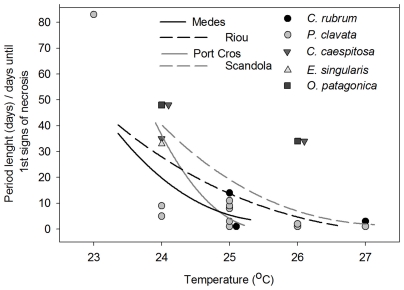
Field T versus experimental thermotolerance data.Inverse second order regression (f = y0+(a/x)+(b/x∧2) fitted to field T data (highest mean T of different length episodes) of the four study regions at 10 m depth (complete and dashed lines) and experimental results (day of 1st signs of necrosis) from different rocky benthic species (grey and black symbols) obtained from the bibliography and the authors' unpublished data (see Table 2). For E. singularis and O. patagonica at 24°C and for O. patagonica at 26°C, the number of days until the 1st signs of necrosis actually indicates the number of experimental days since no necrosis was observed until the last day. The aim of the figure is to represent a composite function over which, under experimental conditions, the species seems to tolerate field T regimes and under which species are affected by tissue necrosis.